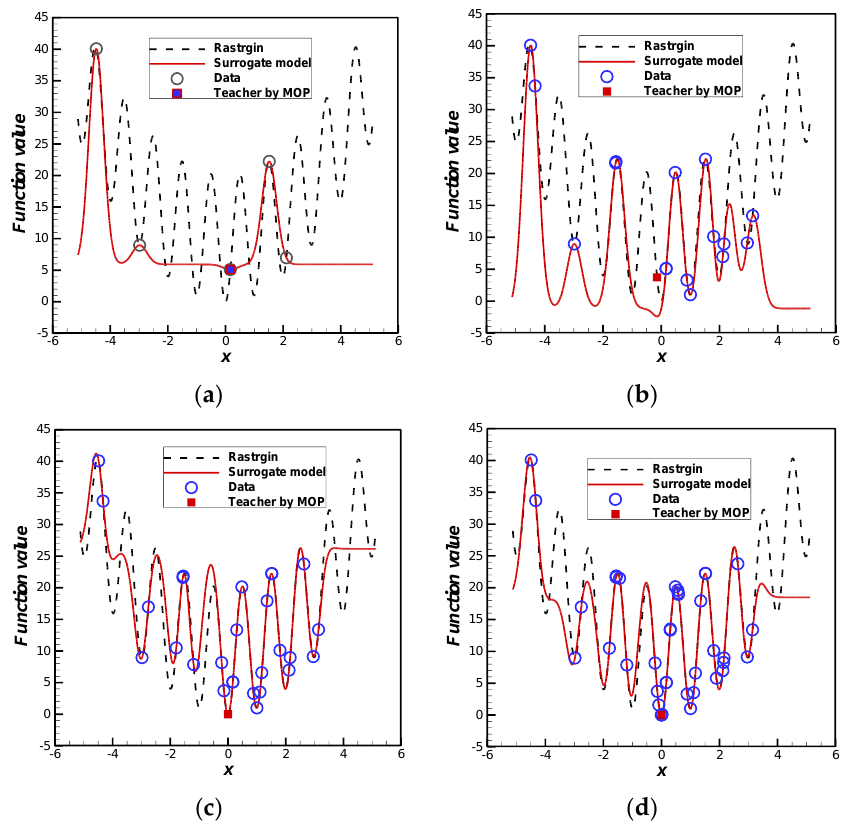
Figure 3. Demonstration of the data-driven optimization process using the one-dimensional Rastrigin function. ( a ) Generation = 1; ( b ) Generation = 2; ( c ) Generation = 3; ( d ) Generation = 4.